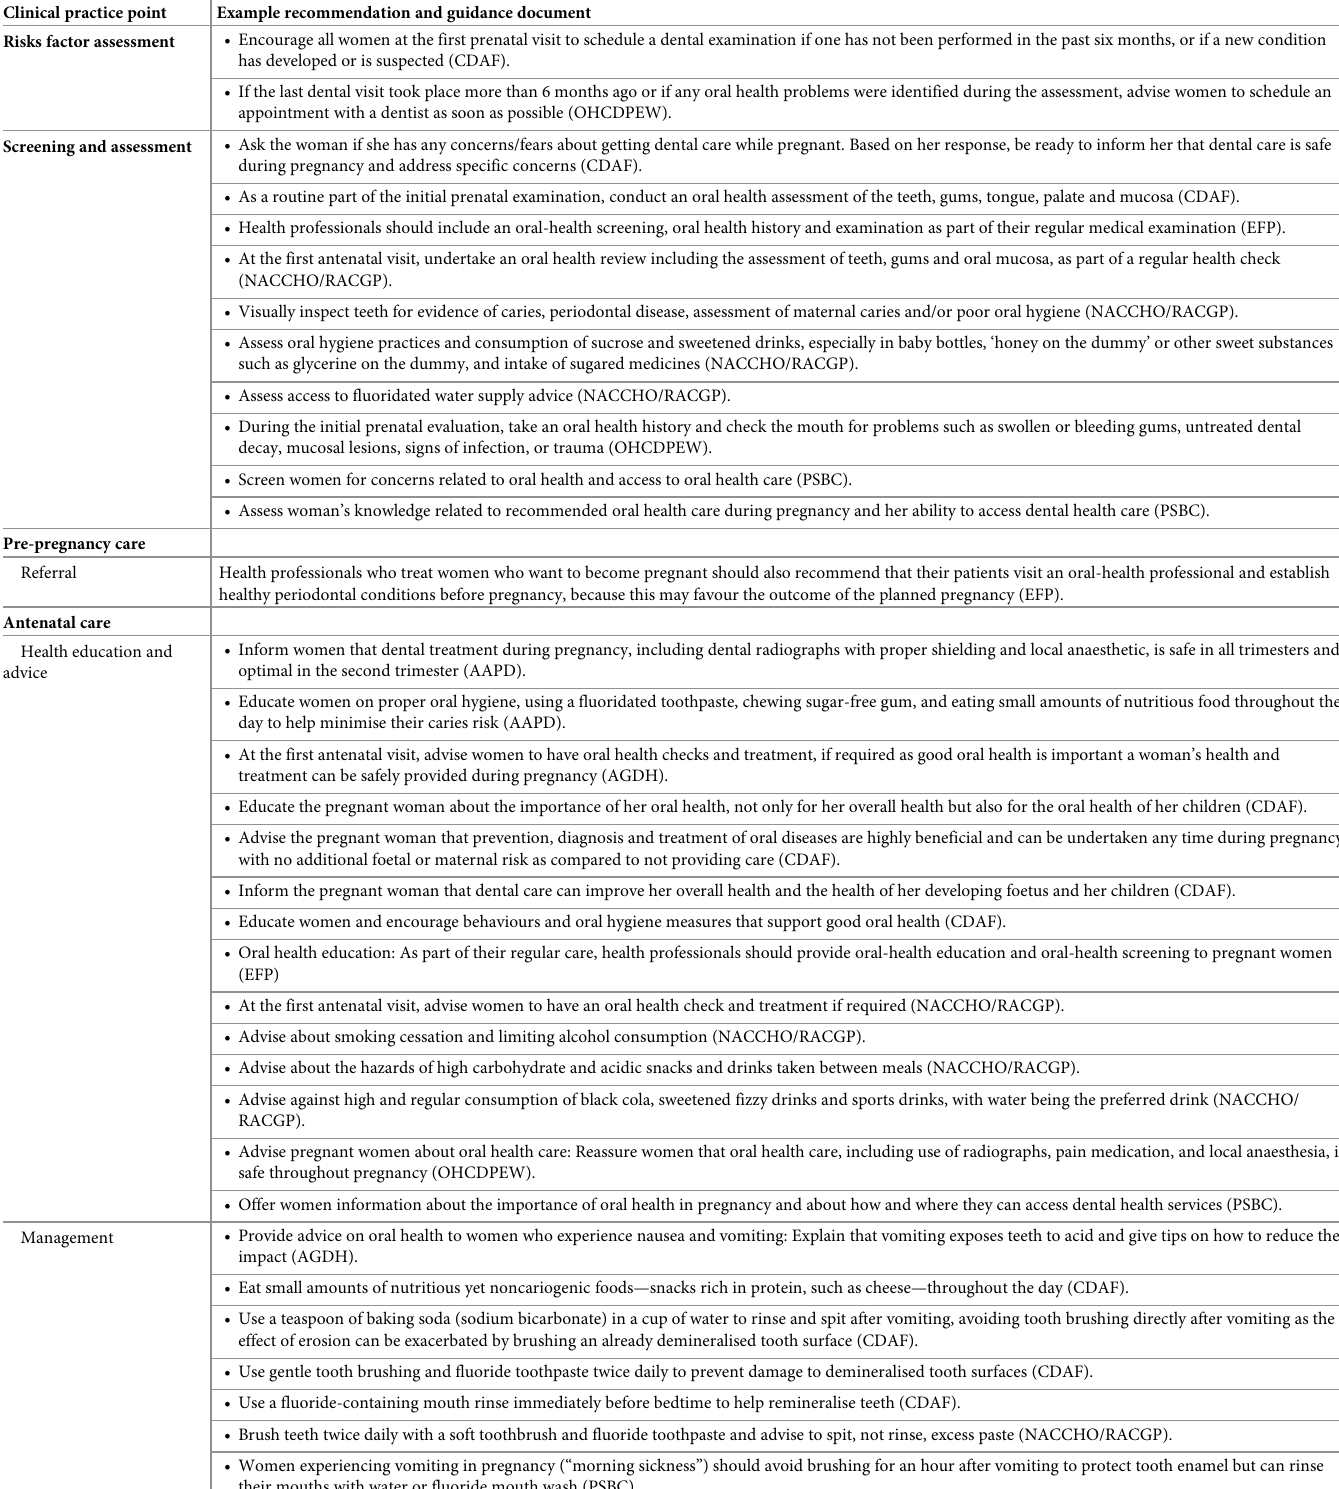
Table 2. Summary of key recommendations within included guidance